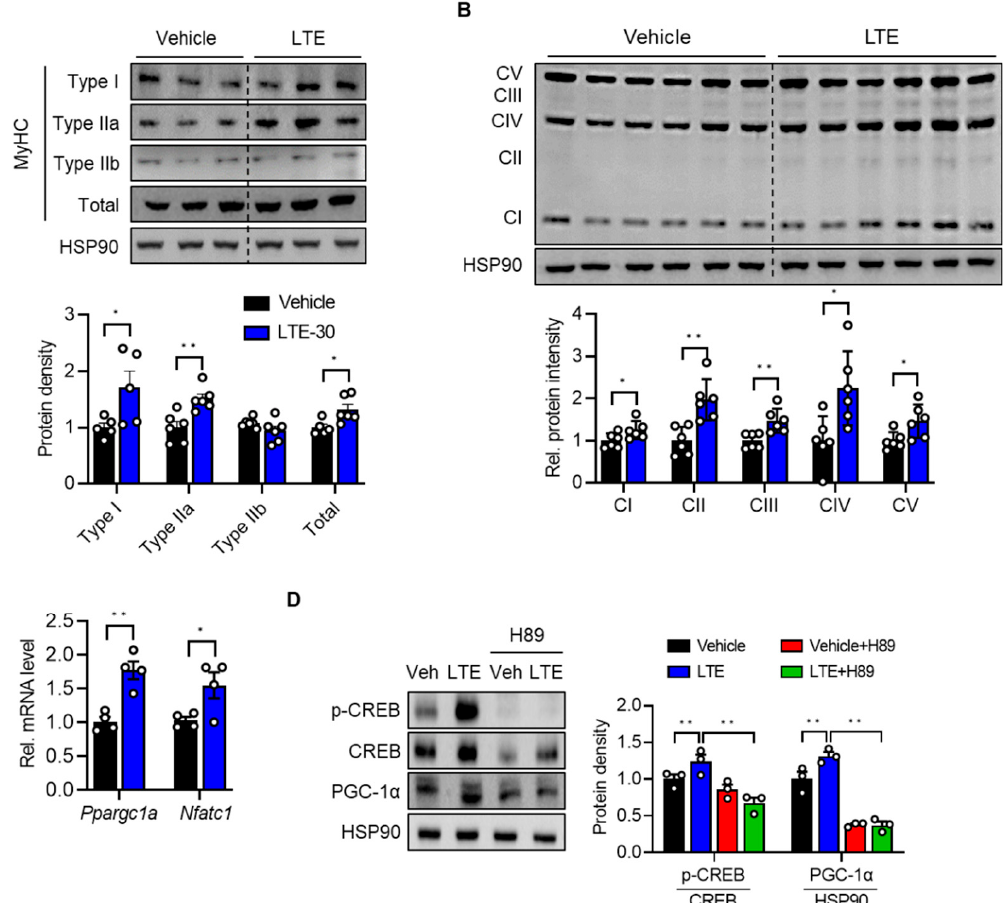
Figure 6. Effects of LTE treatment of C2C12 cells. C2C12 cells were incubated with LTE 30 µ g/mL for 5 days in the differentiation medium. ( A ) Western blotting analysis of MyHC isoforms. Quantification results are shown ( n = 4–6). ( B ) Western blotting for OxPhos proteins ( n = 6). ( C ) qPCR analysis of the expression of Ppargc1a (encoding PGC-1 α ) and Nfatc1 ( n = 4). ( D ) Western blotting analysis after co-treatment of H89 (10 µ M) and LTE. LTE, LTE 30 µ g/mL; MyHC, myosin heavy chain; PGC-1 α , peroxisome proliferator-activated receptor γ coactivator 1 α ; Nfatc1 , nuclear factor of activated T cell 1. Values are mean ± S.E.M. * p < 0.05 and ** p < 0.01.